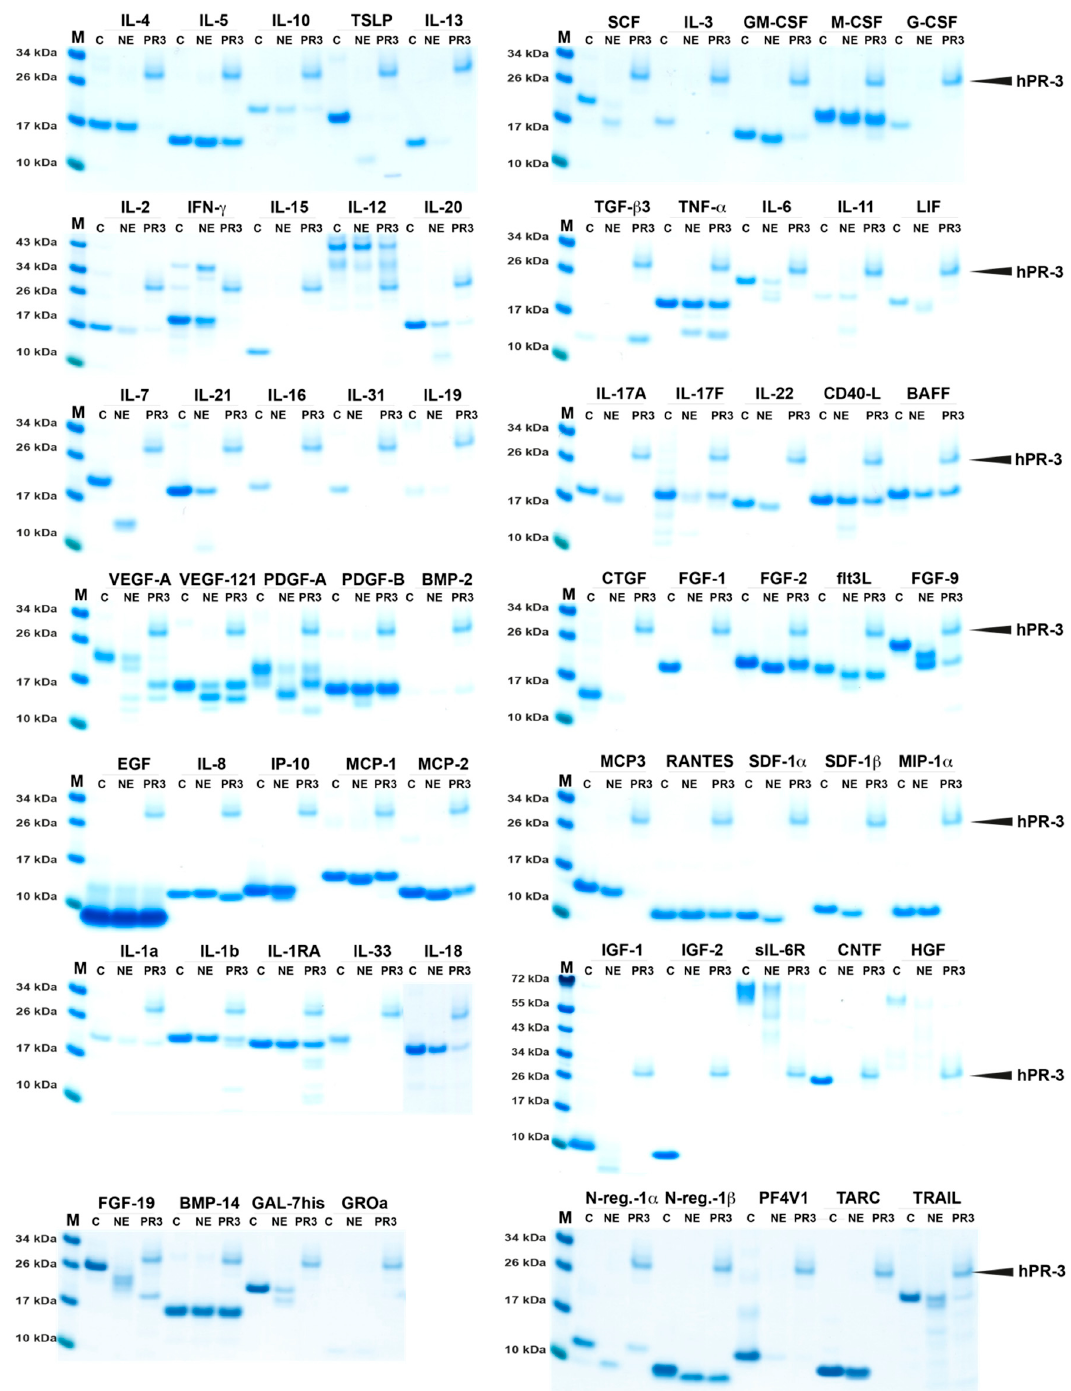
Figure 2. Cleavage analysis of a panel of 69 recombinant human cytokines and chemokines. Four micrograms of the various recombinant cytokines and chemokines in buffer solution were divided to cover the following experiments: one as a negative control (C) where no enzyme was added, one was cleaved with hNE and one with hPR3. The cleavage was performed at 37 °C for 2.5 h. The samples were separated on 4–12% SDS-PAGE gels under reducing conditions. Size markers are found at the left side of each gel. The gels were stained in colloidal Coomassie blue solution. Due to the relatively high concentration of hPR-3 it is visible on the gels and there marked by an arrow. The entire experiment with all the 69 cytokines and chemokines was repeated once with a new batch of cytokines and chemokines and the result was almost identical to what is shown in Figure 2.